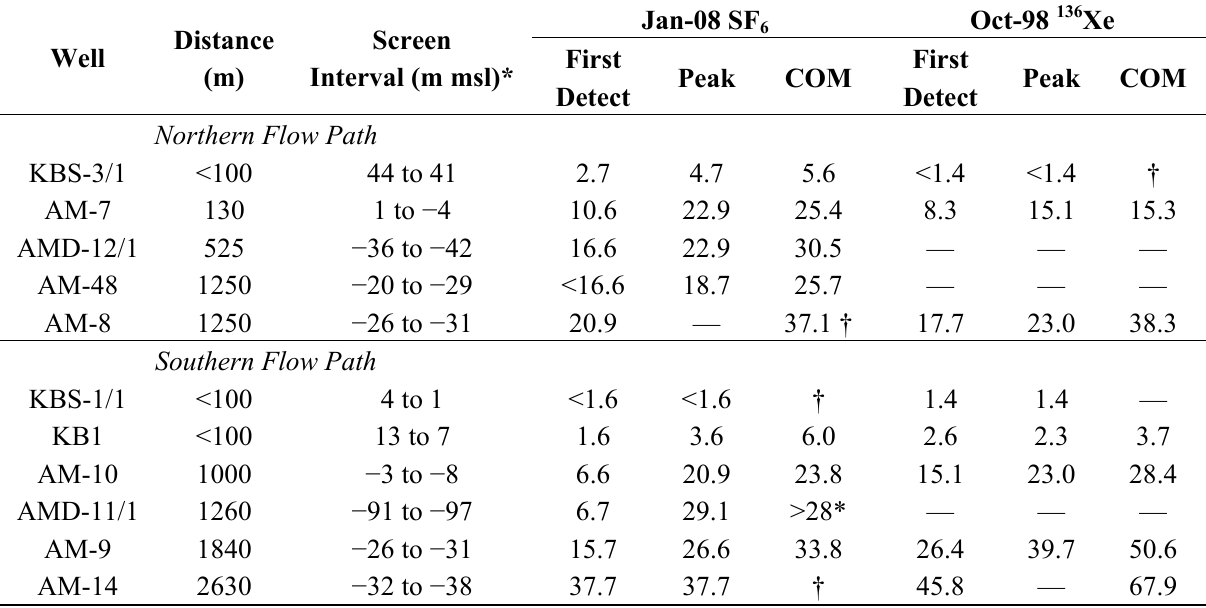
Table 1. Summary of travel times during the Oct-98 136 Xe and Jan-08 SF from Kraemer Basin. The Oct-98 Xe isotope data is from [33]. The distance was measured from the basin’s shoreline directly to the well. This is the shortest distance and does not necessarily represent the flow path length. Travel times are in